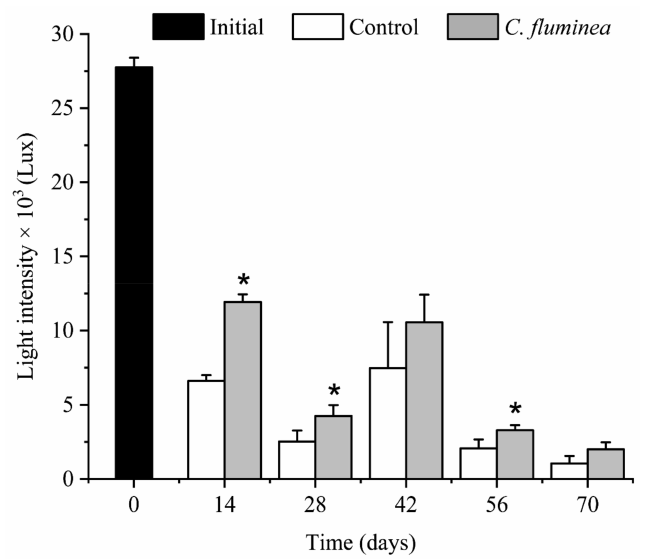
Figure 4. Light intensity (mean ± SD) in different treatments over time. Asterisk indicates significant differences between the treatments and controls ( p < 0.05).